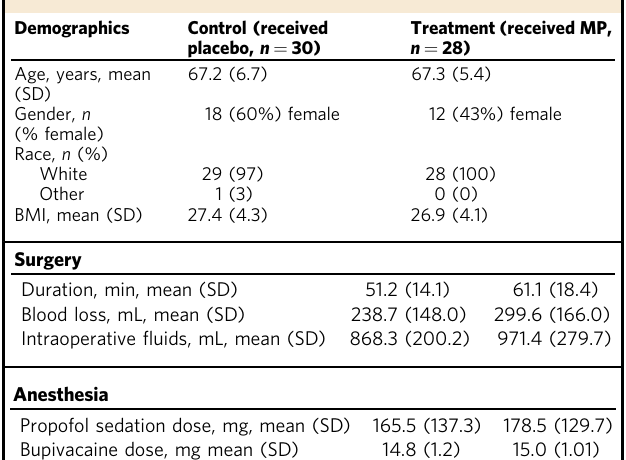
Table 1 Patient and procedural